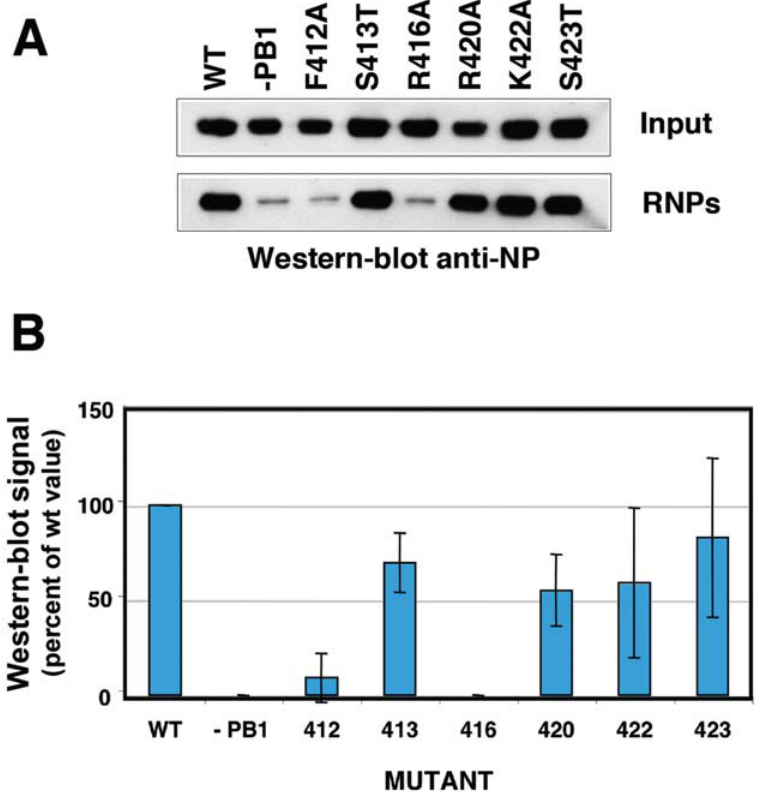
Figure 6. Phenotype of RNPs with NP mutations in the NP-NP interaction site. Recombinant RNPs were generated and amplified in vivo using either wt of mutant NP as indicated. After purification of progeny RNPs by pull-down with Ni-NTA-agarose, their accumulation was determined by Western-blot with anti-NP antibodies. (A) Results of a representative experiment, including the analysis of total cell extracts (Input) and the purified RNPs (RNPs). (B) Average and range of two experiments.